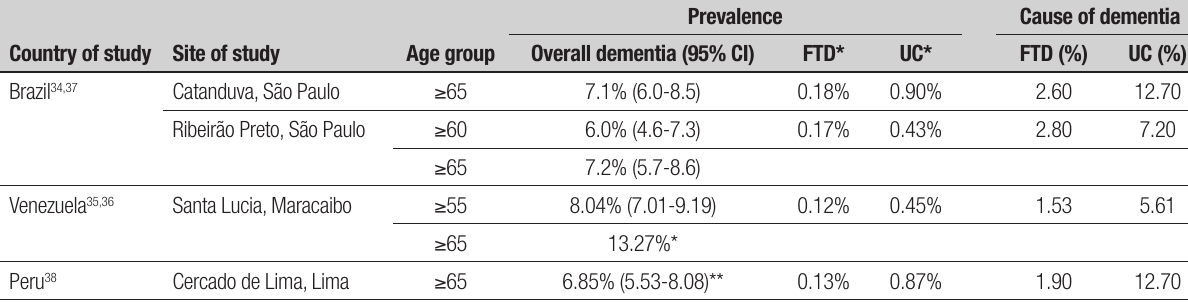
Table 2. Prevalence of frontotemporal dementia and overall dementia in four Latin American studies. Country of study Site of